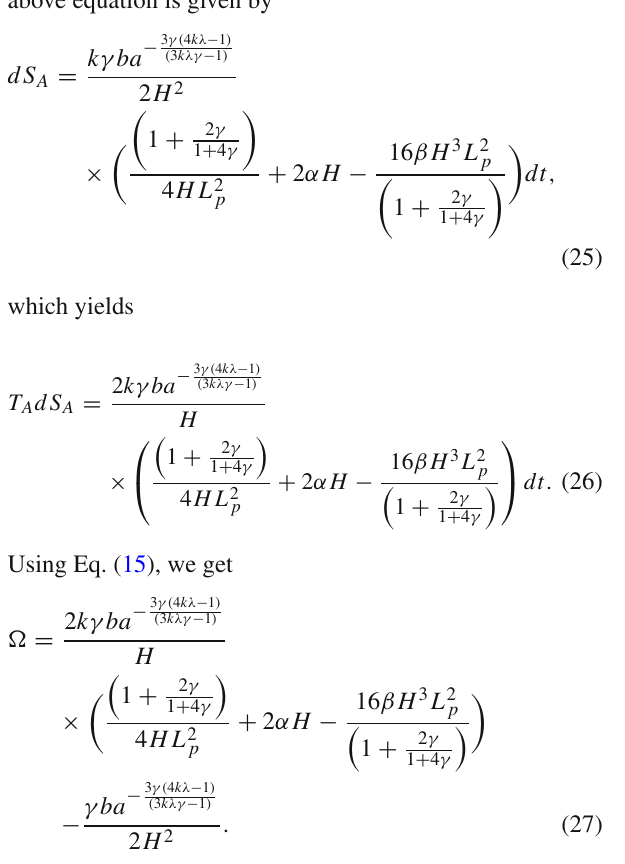
a = 1 . 43 for γ = 1 . 2 and for γ = 1 . 4 at a = 1 . 45 represent the validity of first law of